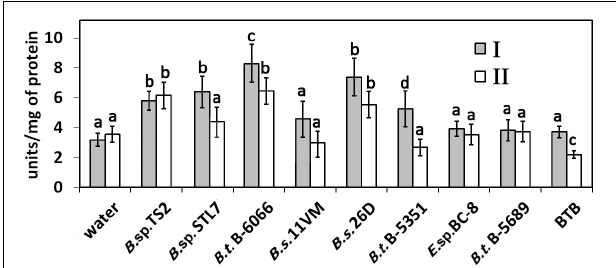
FIGURE 4 | RNase activity in potato plants treated with bacterial strains and Bitoksibacilline (BTB) on the 17th day (I) and the 31st day after treatment (II) . Data represented as mean values ± standard error; values followed by the same alphabet within a column are not significantly different from each other according to Tukey’s honestly significant difference (HSD) multiple-range test at P <